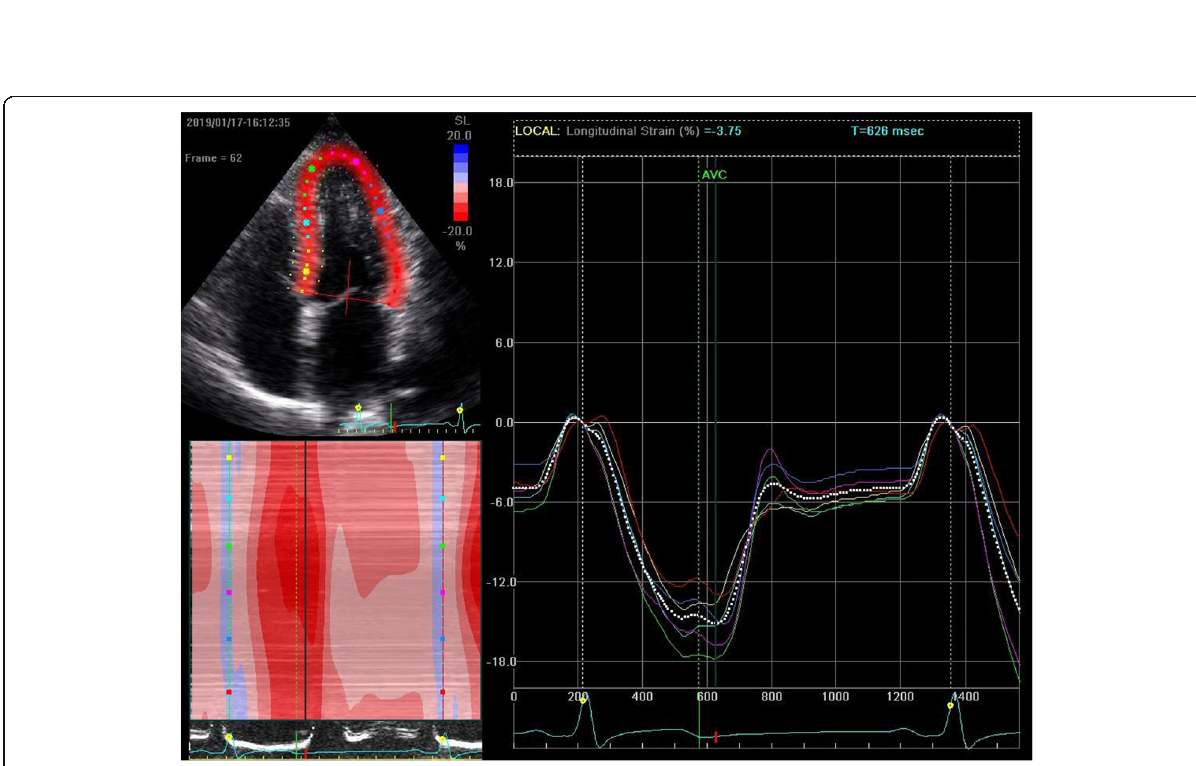
Fig. 2 Measurement of GLS of a patient with DN by 2D-STE. The image was obtained from the apical four-chamber